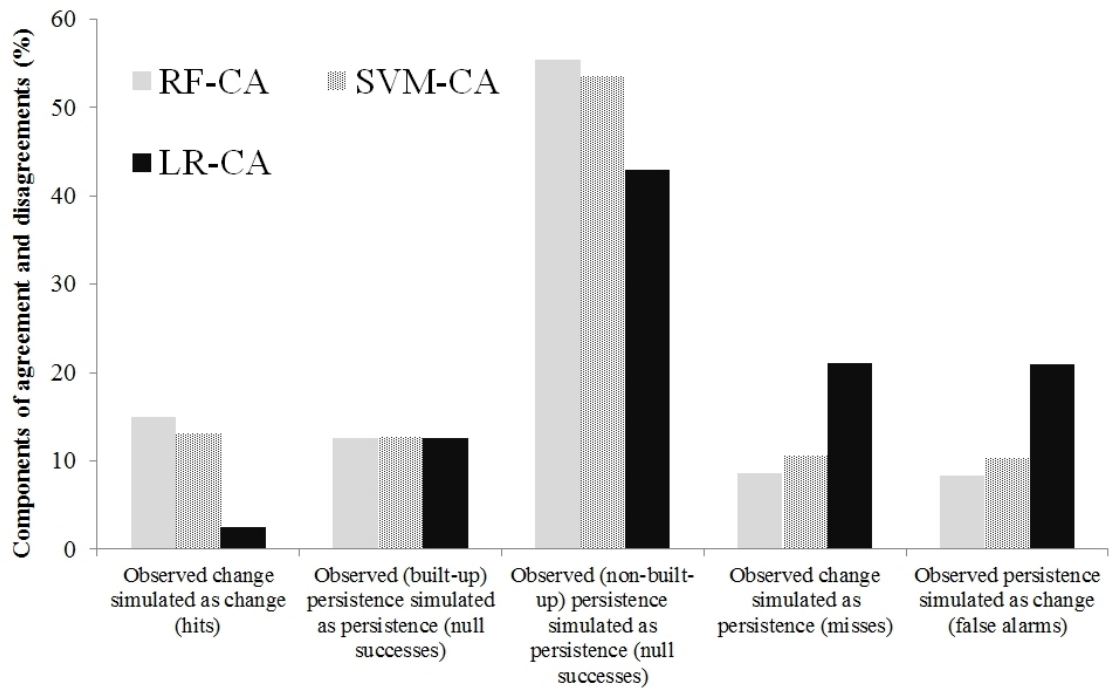
Figure 9. Components of agreement and disagreement expressed as a